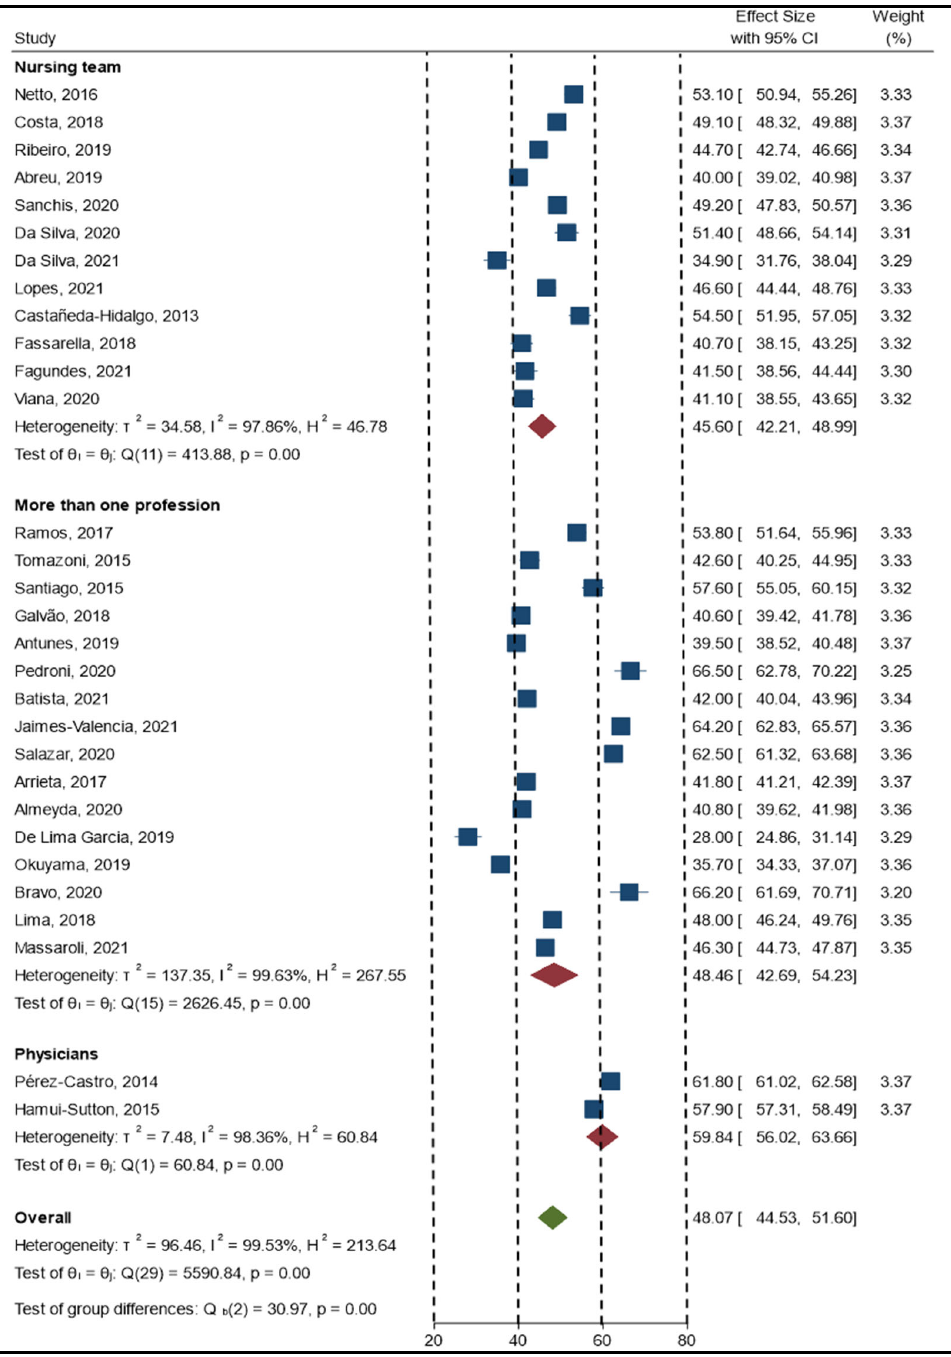
Figure 2. Forest plot of the studies (n = 30) with a positive percent response by professional